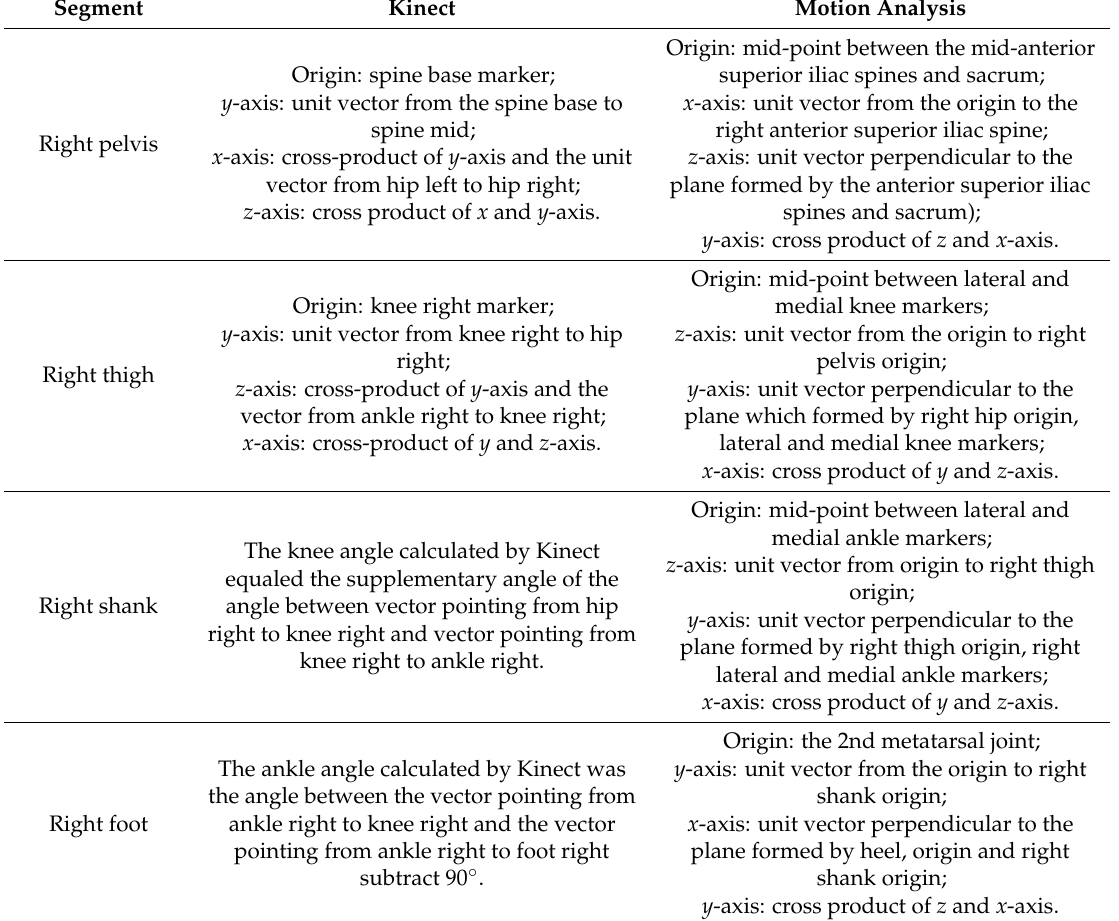
Table 2. Definitions of segment coordinate